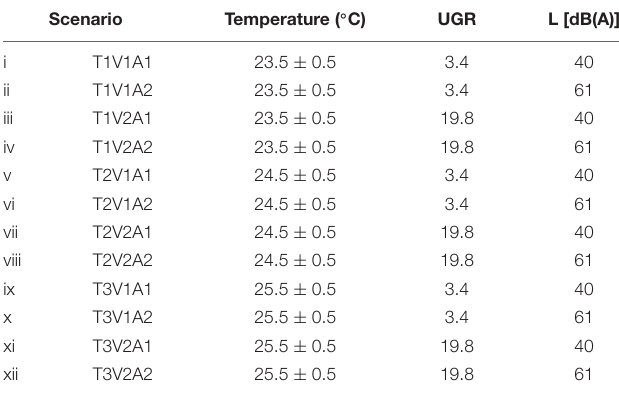
TABLE 3 | Experimental scenario specifications with regard to prevailing thermal (air temperature), visual (glare level), and auditory (ambient sound level) conditions. Scenario